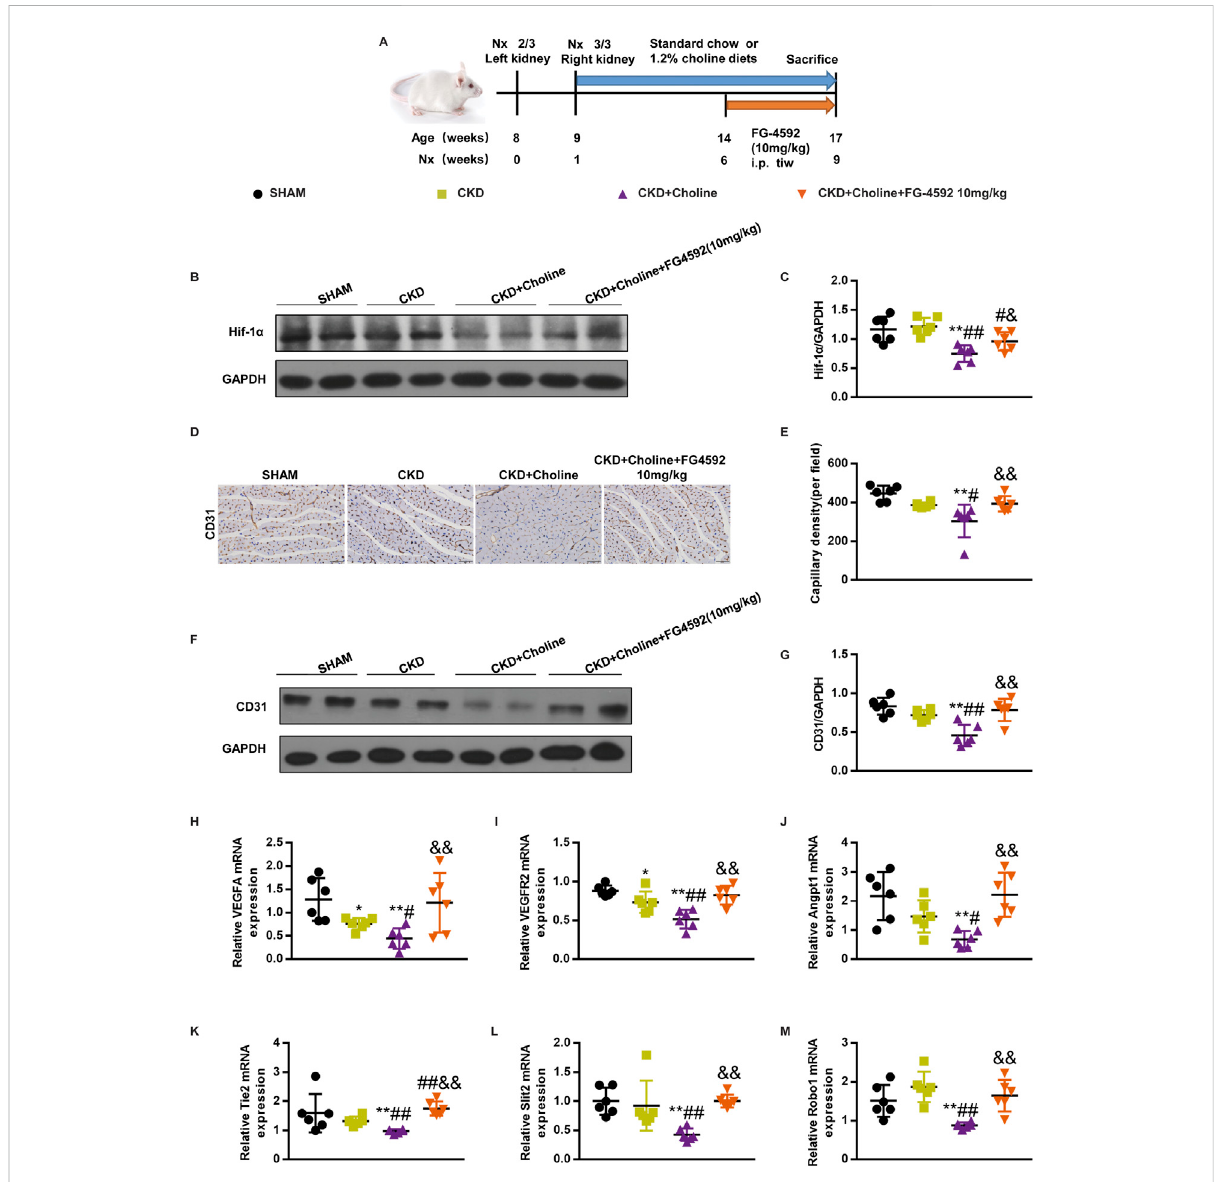
FIGURE 7 FG-4592 increases the expression of cardiac Hif-1 α , and improves cardiac angiogenesis in 5/6Nx mice on a high-choline diet. (A) Schematic designof CKDanimalmodel(5/6 Nx)and treatments. (B) The proteinlevels ofHif-1 α weremeasuredby western blotting. (C) Graphicrepresentation ofrelativeabundanceofHif-1 α normalizedtoGAPDH. (D) RepresentativemicrographsofimmunohistochemistrystainingofCD31intheheart.Scale bar = 50 μ m. (E) Graphical representation of capillary density analysis. (F) The protein levels of CD31 were measured by western blotting. (G) Graphic representation of relative abundance of CD31 normalized to GAPDH. (H – M) The mRNA levels of VEGF, Angpt1, Slit2, VEGFR2, Tie2 and Robo1 were measured by real-time PCR. The data are presented as the mean ± SD. * p < 0.05 and ** p < 0.01 vs. SHAM group; # p < 0.05 and ## p < 0.01 vs. CKD group. & p < 0.05 and && p < 0.01 vs. CKD + Choline group n = 6 in each